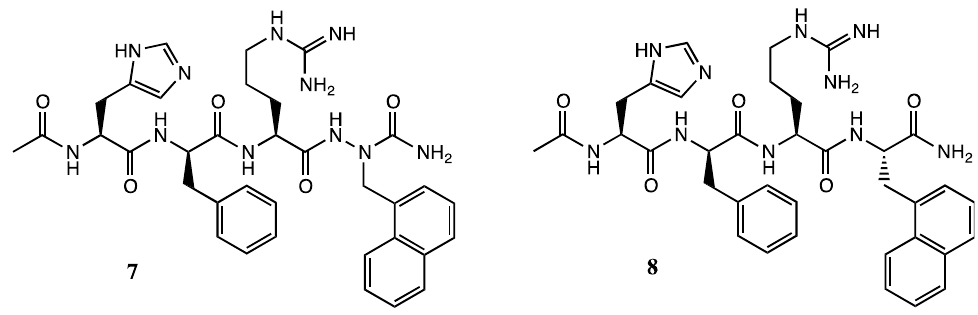
Figure 3. [aza-Nal-2 4 ]MSH 7 and [ L -Nal-2 4 ]MSH 8 analogs.